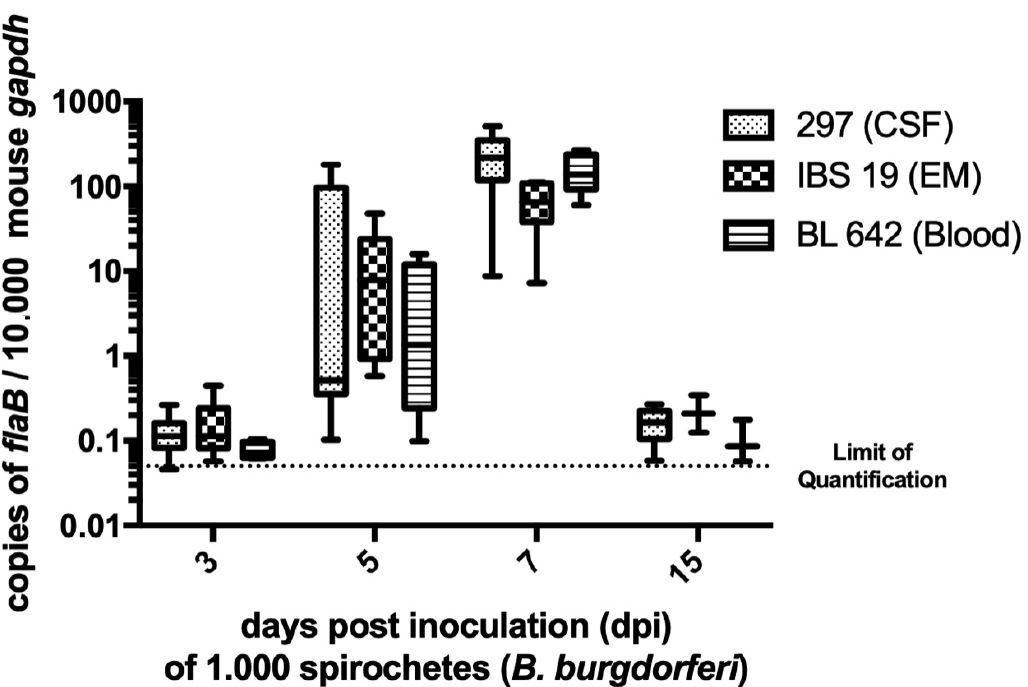
Figure 1. Borrelia load in the mouse skin. The spirochetal burden in the skin at the inoculation site was measured by quantitative PCR for the Borrelia flagellin ( flaB ) gene and normalized to copies of mouse glyceraldehyde-3-phosphate dehydrogenase ( gapdh ). Values presented in box plot correspond to relative quantification in each positive mouse skin (all the mice referred to as positive in Table 1). In each box plot, the box embraces values between the first and third quartile, the median is a line, the higher error bar corresponds to the maximum value, and the lower error bar corresponds to the minimum value. Limit of quantification was around 0.05 flagellin copies per 10.000 murine gapdh . Medians of bacterial load were statistically compared [1] within strains at the same day and [2] for a same strain at each time post-inoculation. The bacterial load reached maximum density for the three strains on day 7 ( p -values < 0.05). Values of bacterial load were not statistically di ff erent between strains at each time point, except for strain IBS 19 that exhibited a lower median value of spirochetal load on day 7 ( p -value < 0.01). Abbreviations: CSF, cerebrospinal fluid; EM, erythema